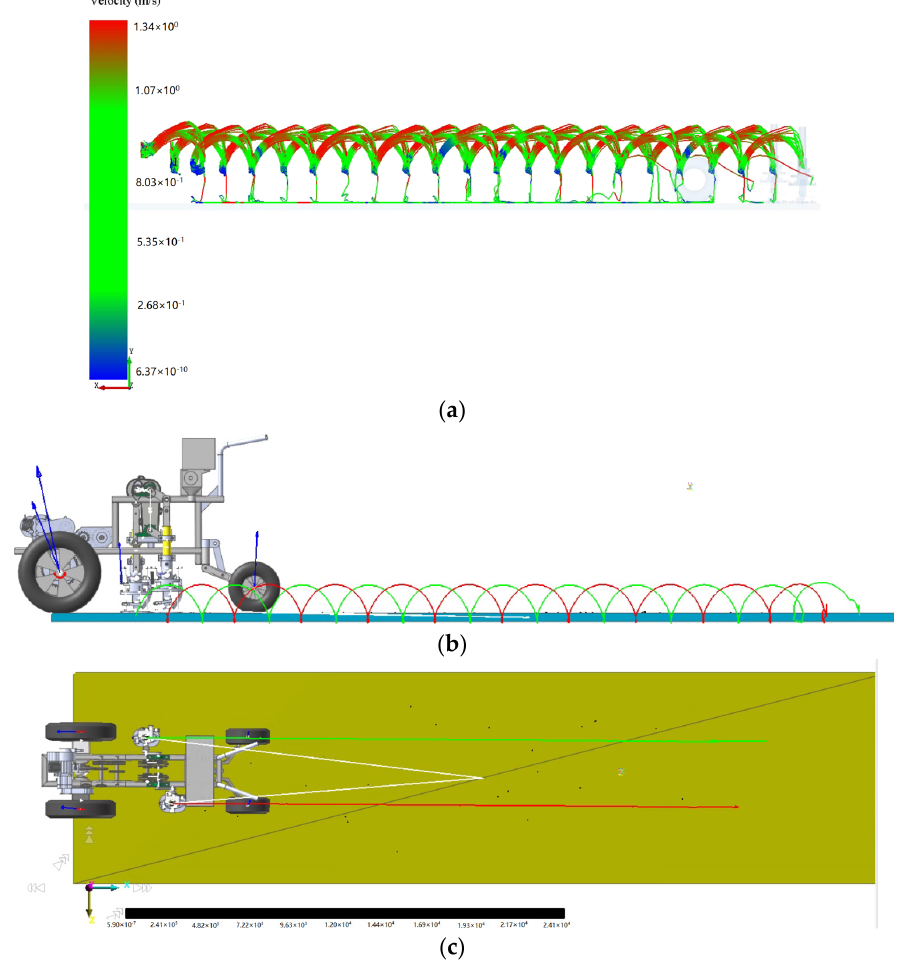
Figure 21. Simulation seeding performance of the cavity planter with vertical insertion. ( a ) Seed movement trajectory. ( b ) Trajectory of the cavity seeder (main view). ( c ) Trajectory of the cavity planter (top view).